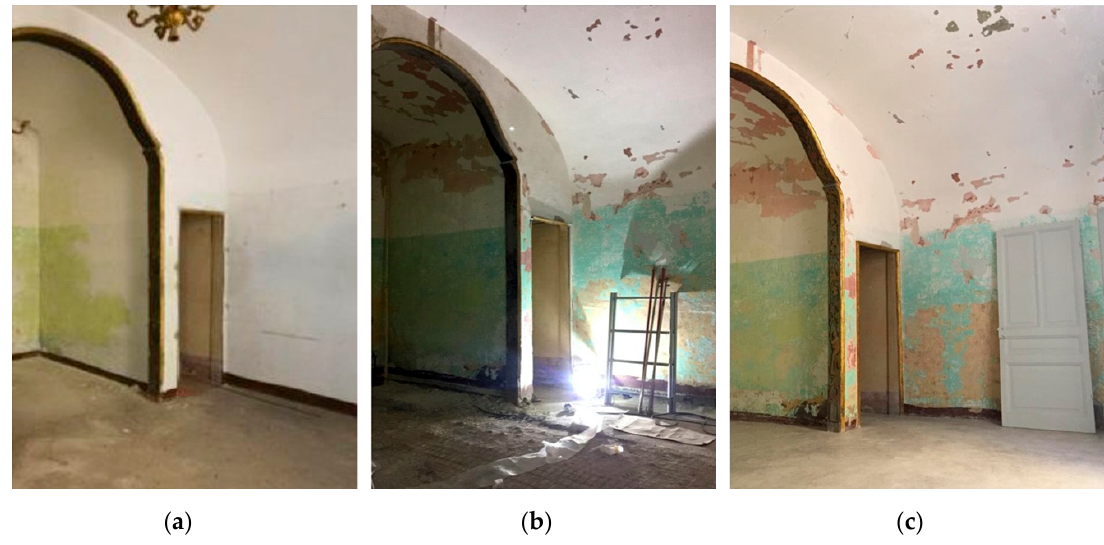
Figure 18. ( a ) Floor before starting work (room with alcove), ( b ) demolition of the floor and ( c ) new